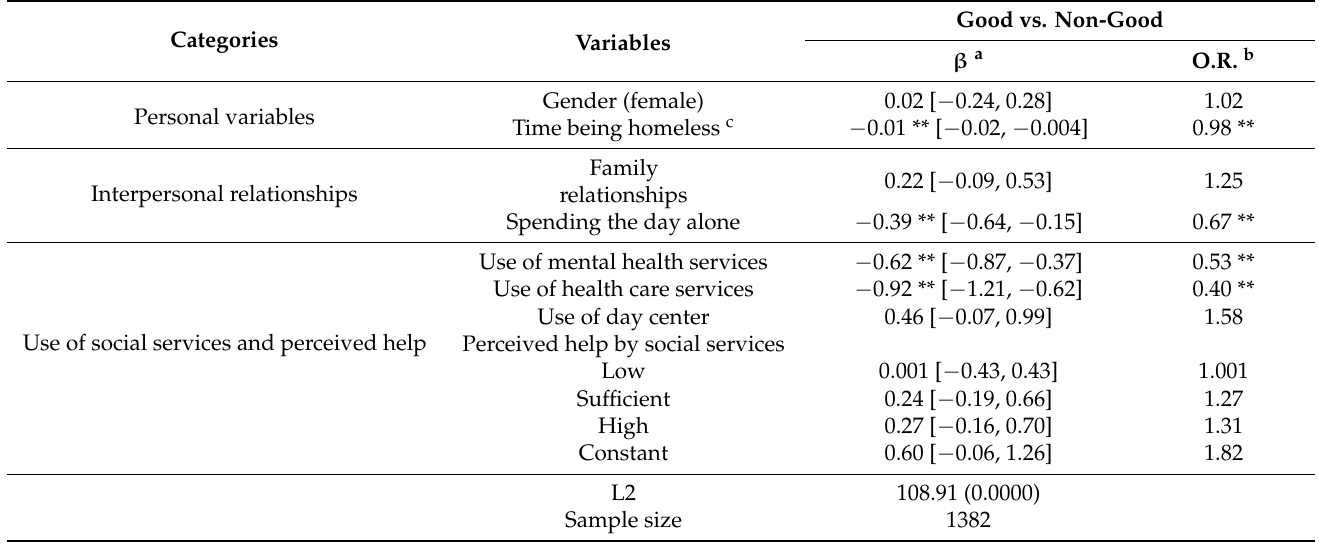
Table A2. Impact of some variables on a good self-perceived health status (binary logit).